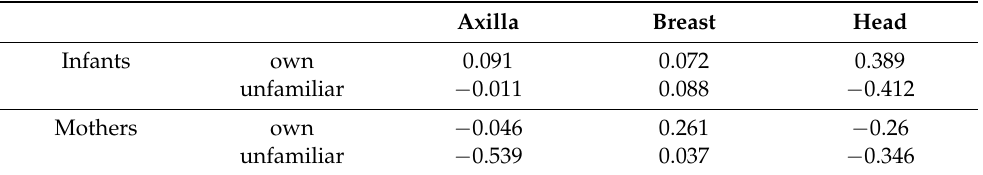
Table A6. Heatmap for the Pearson’s correlation coefficients of pleasantness and intensity ratings for each body site and for both familiar and unfamiliar odours; yellow indicates a negative correlation, white indicates a null correlation, blue indicates a positive